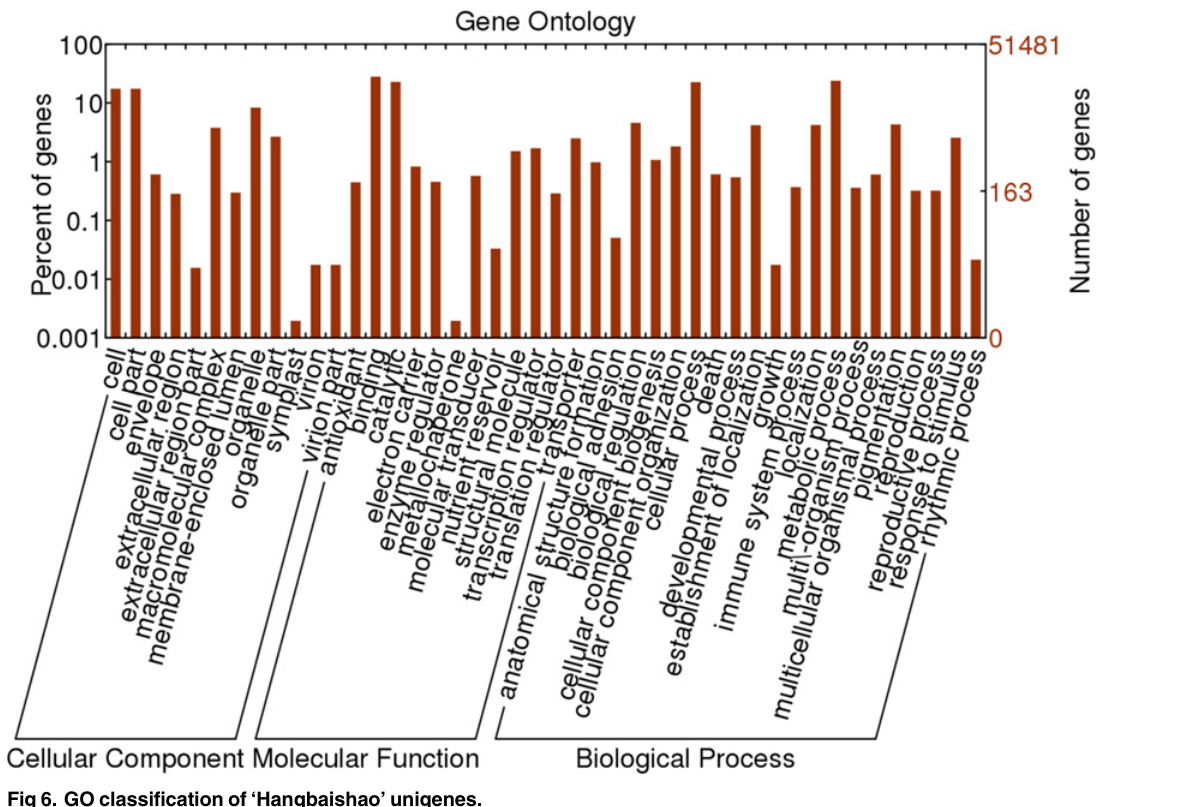
Fig 6. GO classification of ‘ Hangbaishao ’